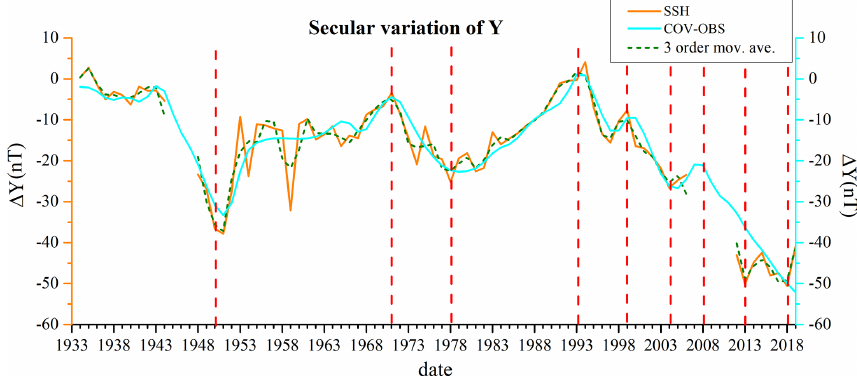
Figure 16. The SV of the annual Y series from the SSH and COV-OBS